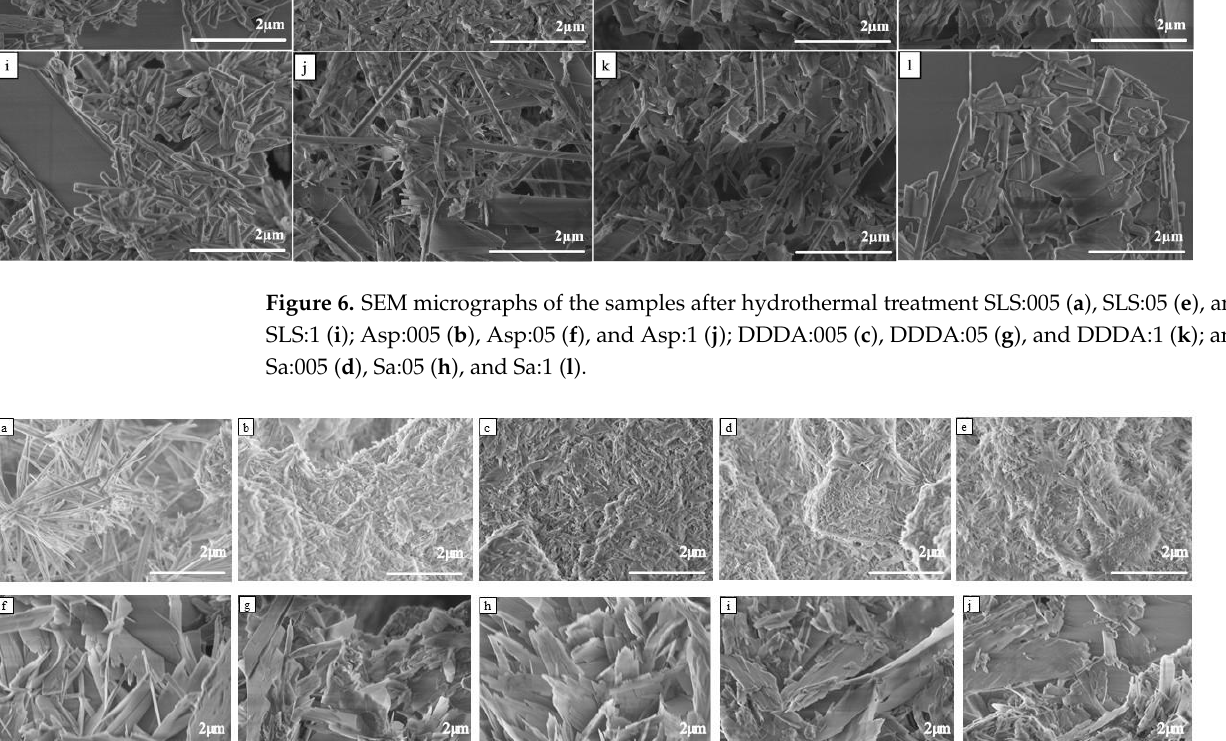
Figure 6. SEM micrographs of the samples after hydrothermal treatment SLS:005 ( a ), SLS:05 ( e ), and SLS:1 ( i ); Asp:005 ( b ), Asp:05 ( f ), and Asp:1 ( j ); DDDA:005 ( c ), DDDA:05 ( g ), and DDDA:1 ( k ); and Sa:005 ( d ), Sa:05 ( h ), and Sa:1 ( l ).